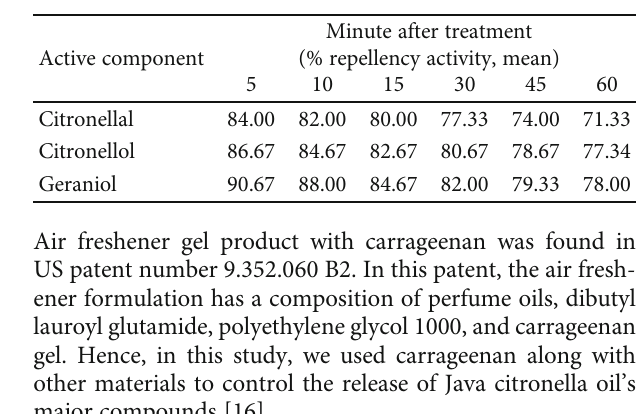
Table 1: Several formulas of air freshener gel with 1% Java citronella oil.